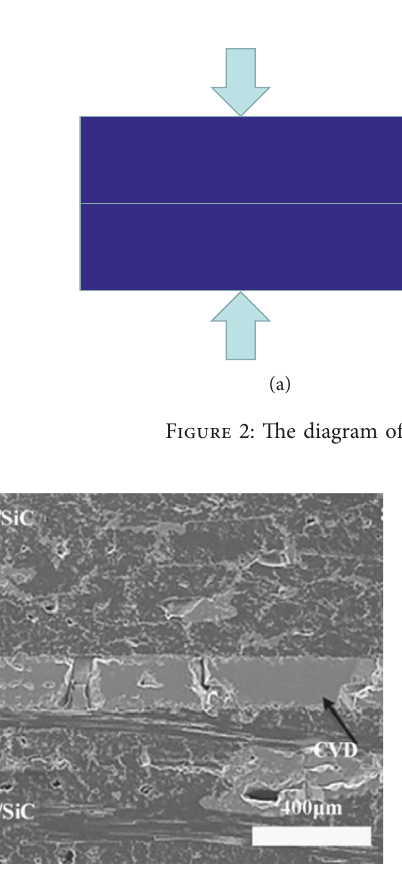
Figure 3: Scanning electron microscopy of polished cross sections of C f /SiC specimens joined by SPS: direct bonding [48]. Table 2: CTE of typical materials (room temperature).